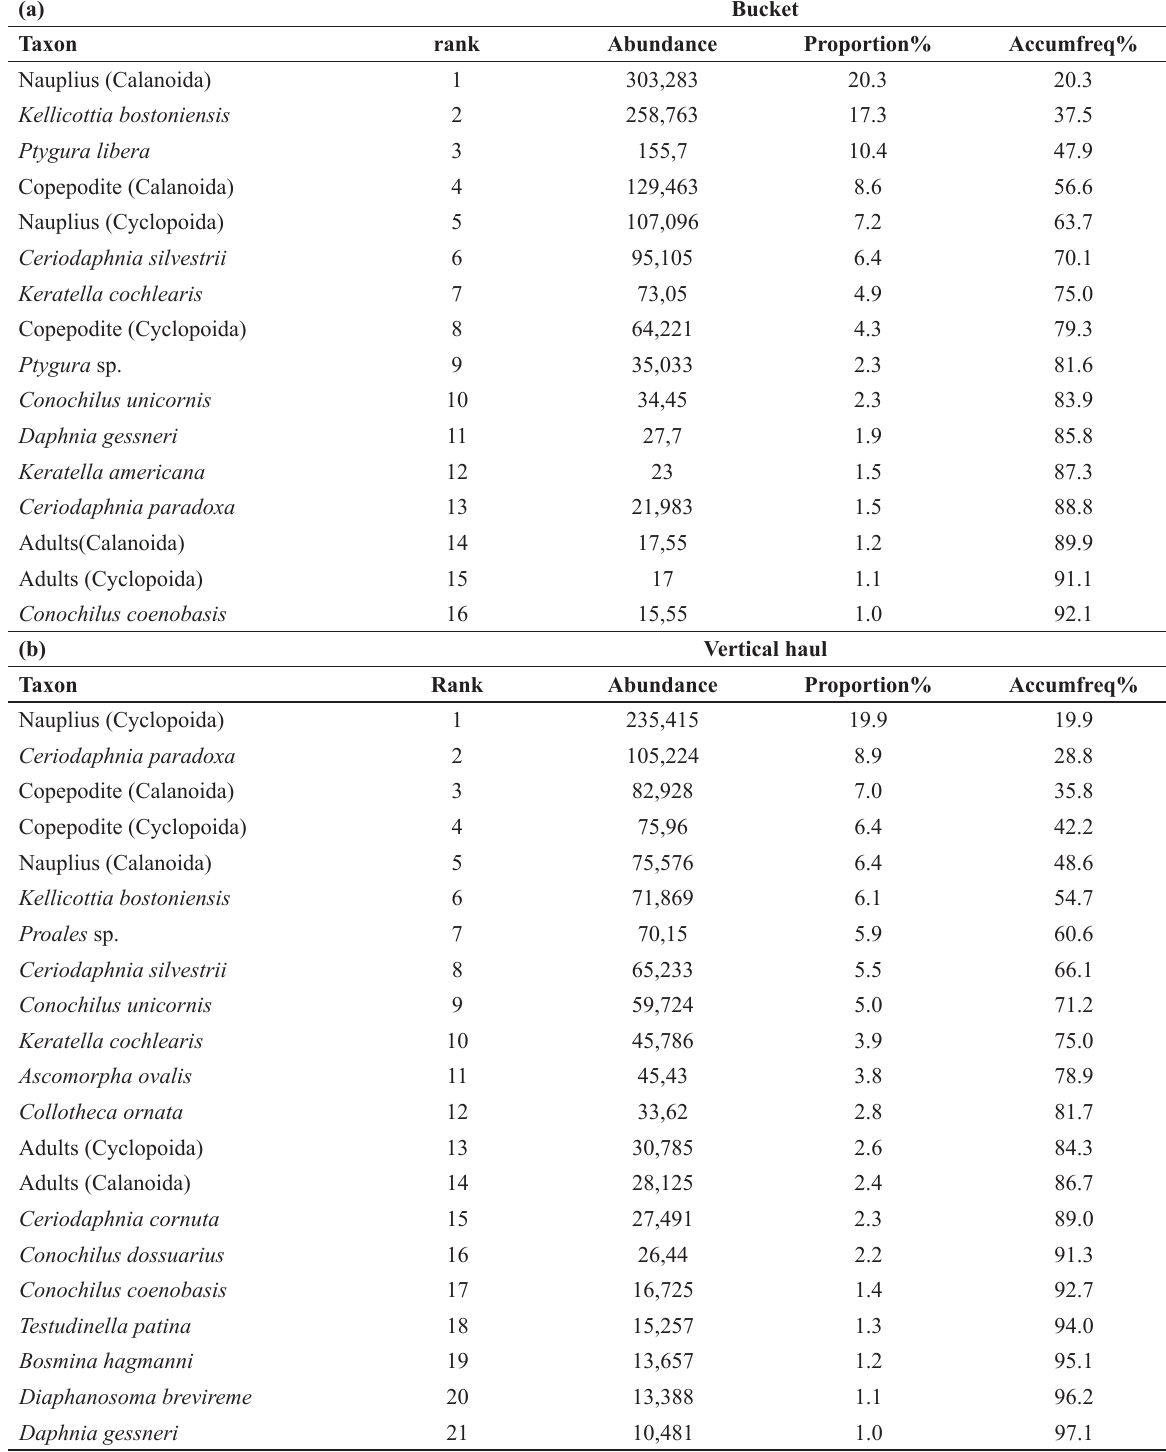
Taxa collected with bucket (a) and vertical haul (b). “Rank” of taxa from most abundant to representability of 1%. Total “Abundance” found in ind/m³. “Proportion%” is the percentage of the representation in terms of abundance. “Accumfreq%” is an accumulative rank in terms of